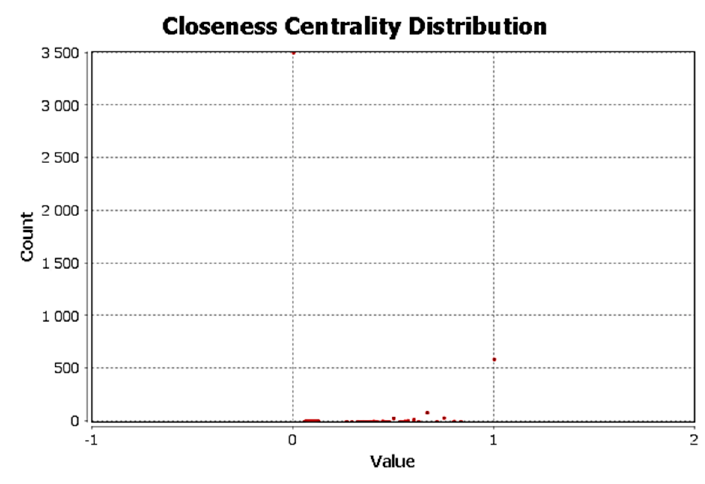
Figure 10. The closeness centrality distribution of network ‘B’.